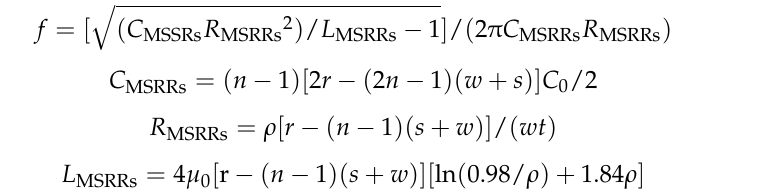
Figure 1. ( a ) Current flow diagram; ( b ) equivalent circuit diagram.